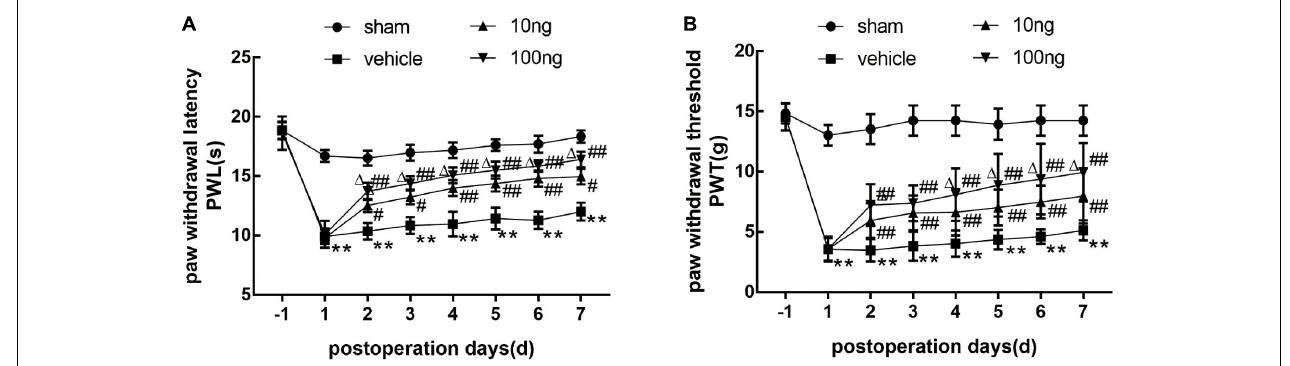
FIGURE 1 | Application of MaR1 regulated pain behavior in a rat model of NCLDH ( n = 8/group). (A,B) MaR1 (10 or 100 ng) reversed PWL and PWT induced by NCLDH from the 2nd day to the 7th postoperative day. Data are presented as the mean ± SD (** P < 0.01 versus the sham group; ## P < 0.01 versus the vehicle group; # P < 0.05 versus the vehicle group; (cid:49) P < 0.05 versus the 10 ng MaR1 group).